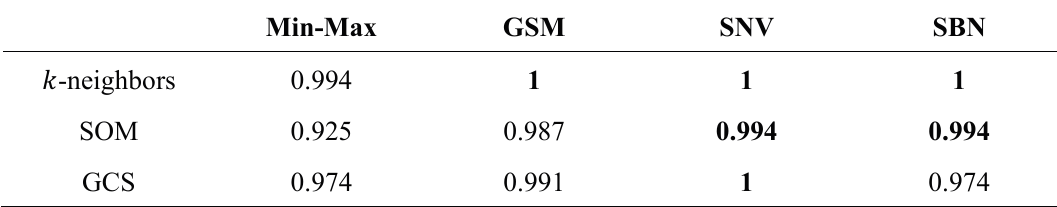
Table 4. Kappa indices obtained with the three classification techniques and the four normalization methods when denoising with the weighted moving average (WMA) method (Gaussian window with (cid:2026) (cid:2870)